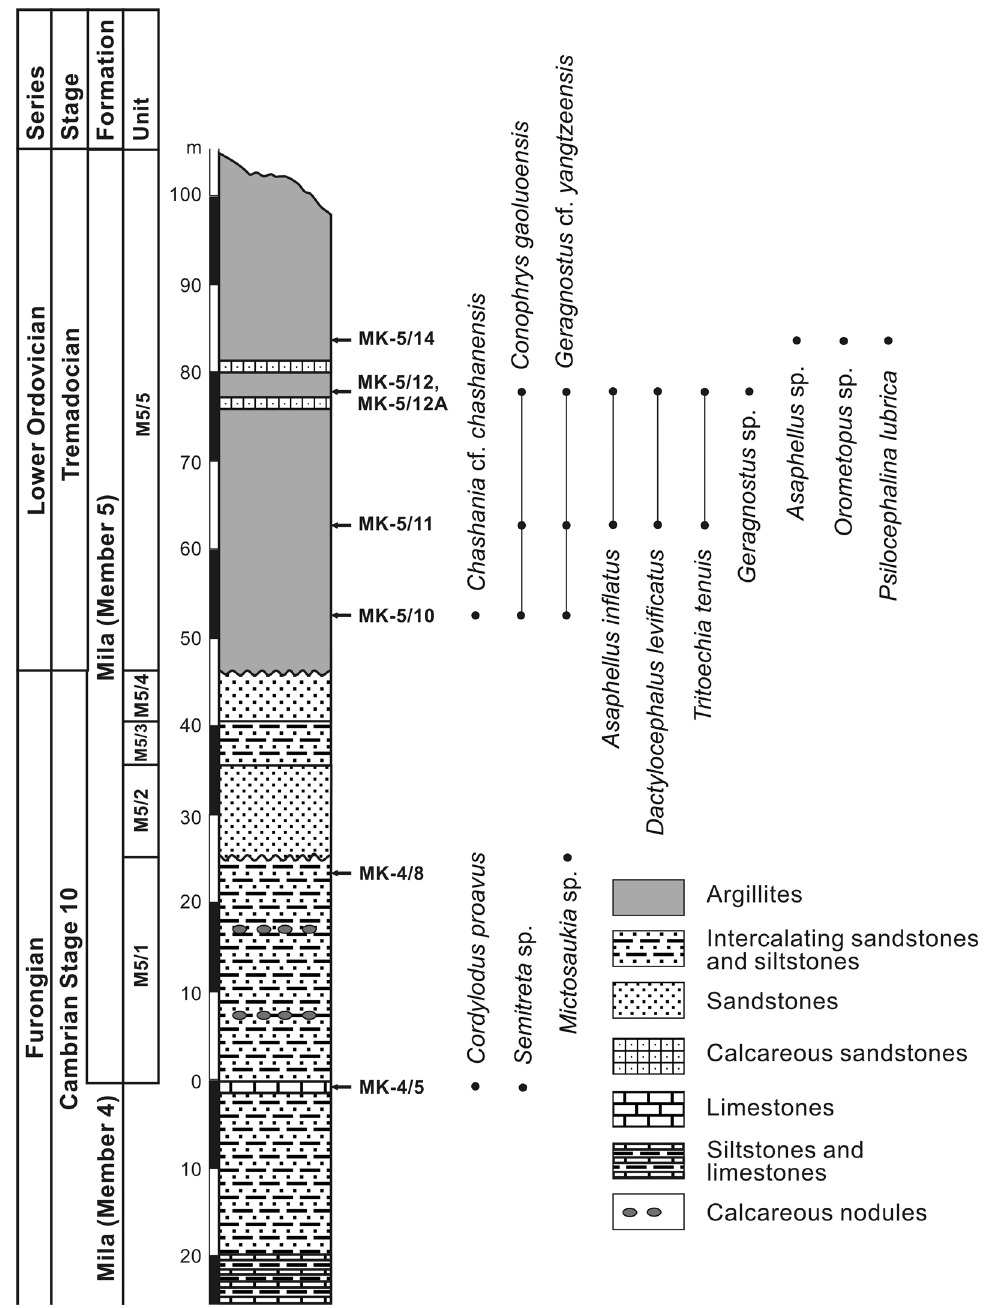
Fig. 2. Stratigraphical column of Mila Formation Member 5 in Mila-Kuh, showing the horizons of fossil localities and stratigraphical ranges of trilobite, brachiopod and conodont